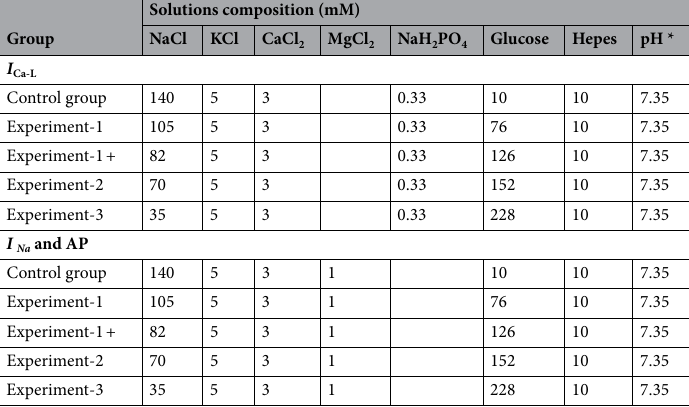
Table 1. The extracellular fluid used in electrophysiological experiments. *Adjust pH with